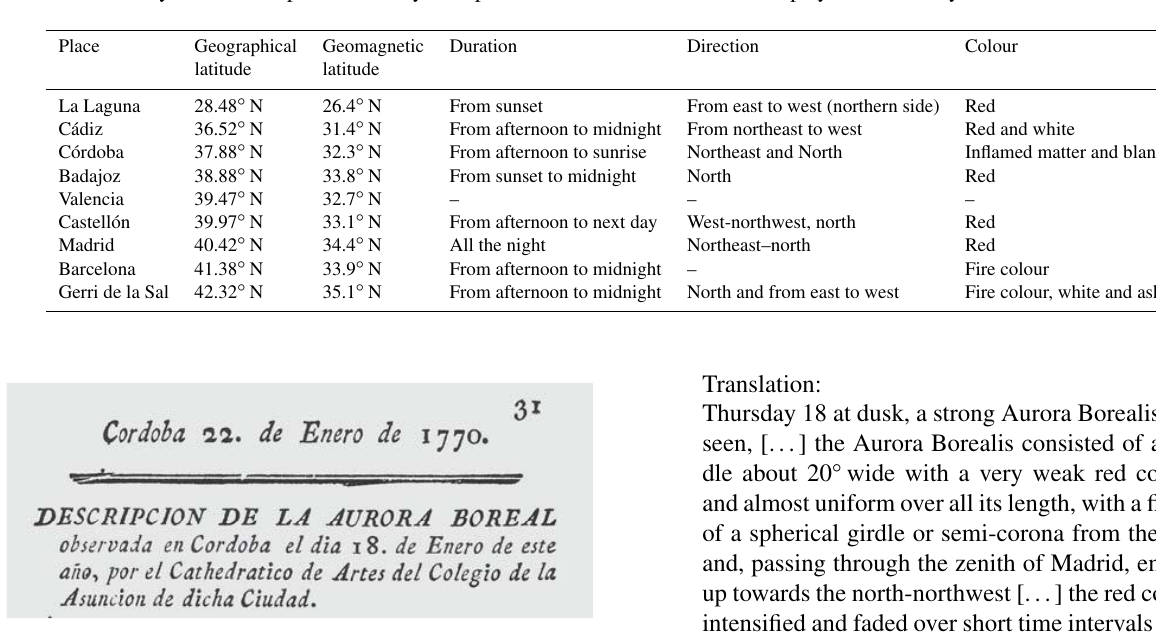
Figure 2. Header of the article about the observation of aurora made by the Professor of Arts of the Colegio de la Asunción in Córdoba on 18 January 1770 (Source: Nipho,